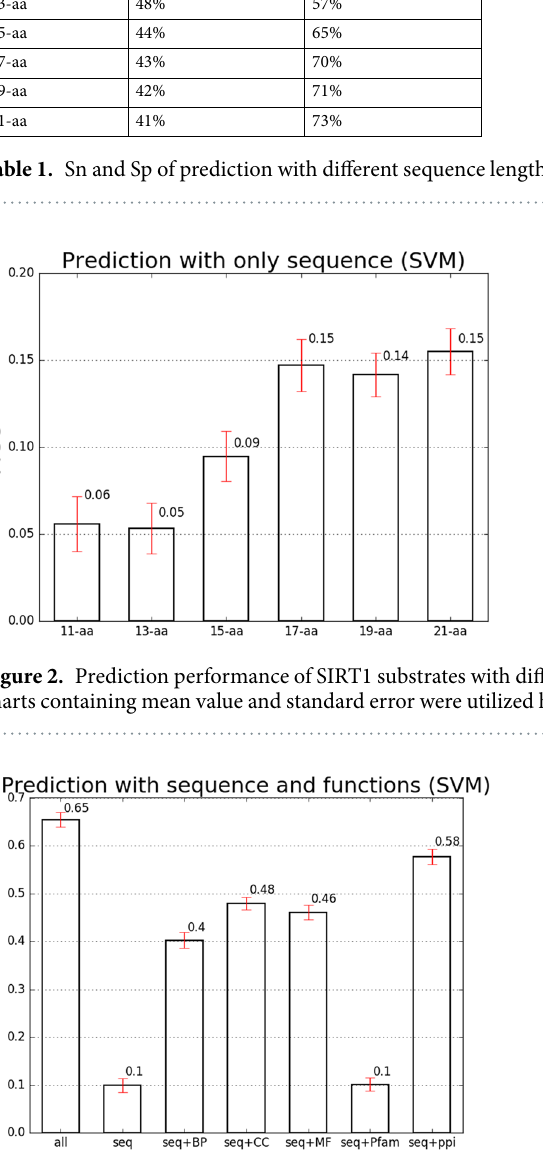
Figure 3. Prediction performance of SIRT1 substrates with sequence and functional features based on SVM. Error bar charts containing mean value and standard error were utilized here to visualise MCC